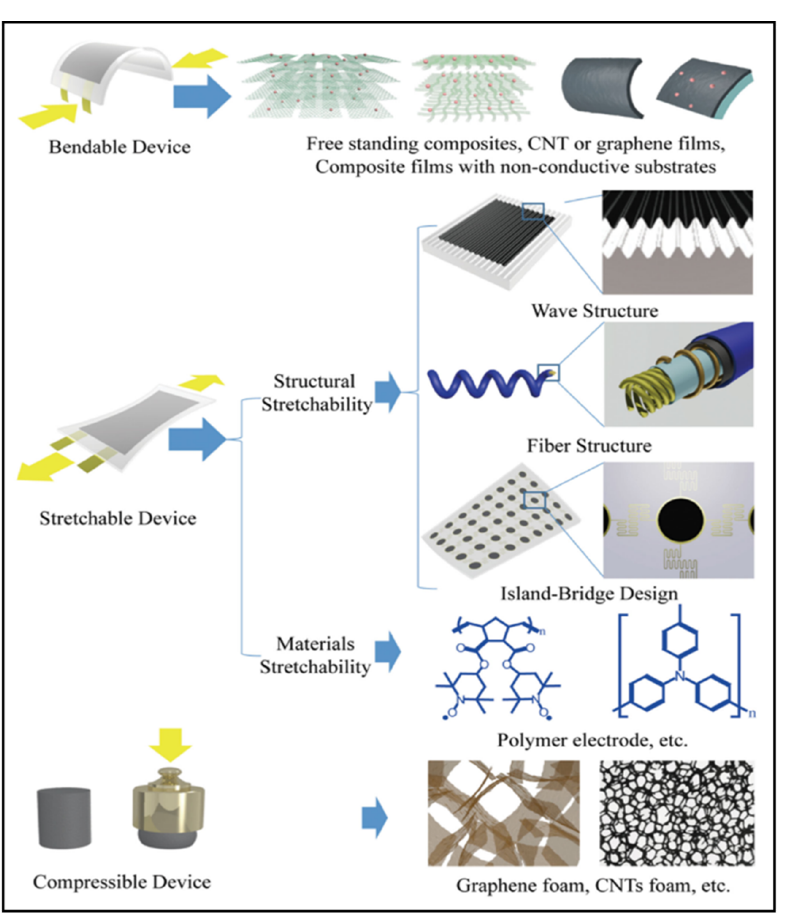
Figure 8. Structures and applications of CNTs and graphene [87]. Reprinted with permission from Ref. [87]. Copyright© 2022 WILEY-VCH Verlag GmbH & Co. KGaA, Weinheim.